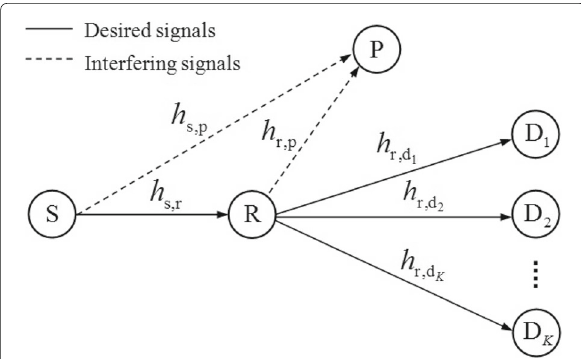
Fig. 1 Cognitive dual-hop AF network with MUSwiD user selection